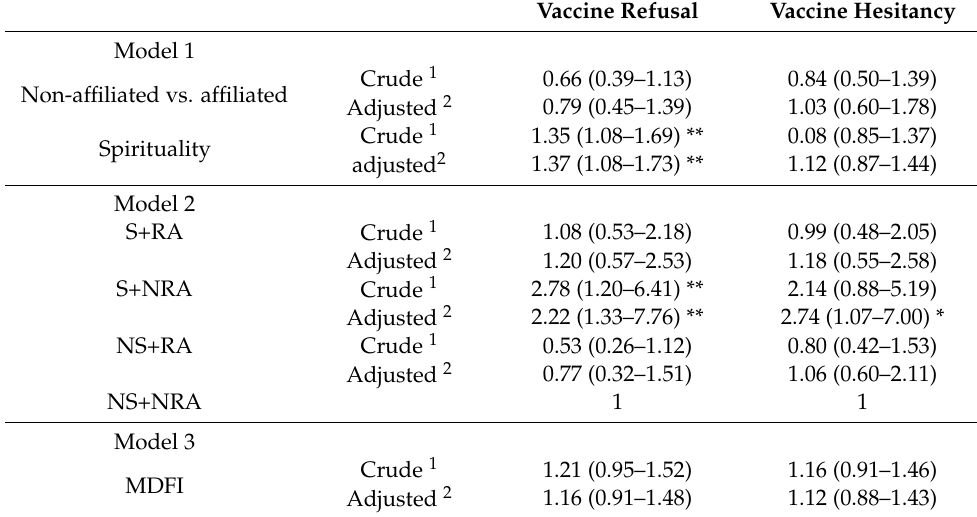
Table 3. Associations of religious affiliation, spirituality (standardised to Z-scores), different combina- tions of religious affiliation and spirituality, and religious fundamentalism (standardised to Z-scores) with attitudes towards COVID-19 vaccination: results of multinominal logistic regression crude and adjusted for age, gender, and education level, leading to odds ratios (OR) with 95% confidence intervals. Vaccine Refusal Vaccine Hesitancy Model 1 Crude 1 0.66 Non-affiliated vs. affiliated